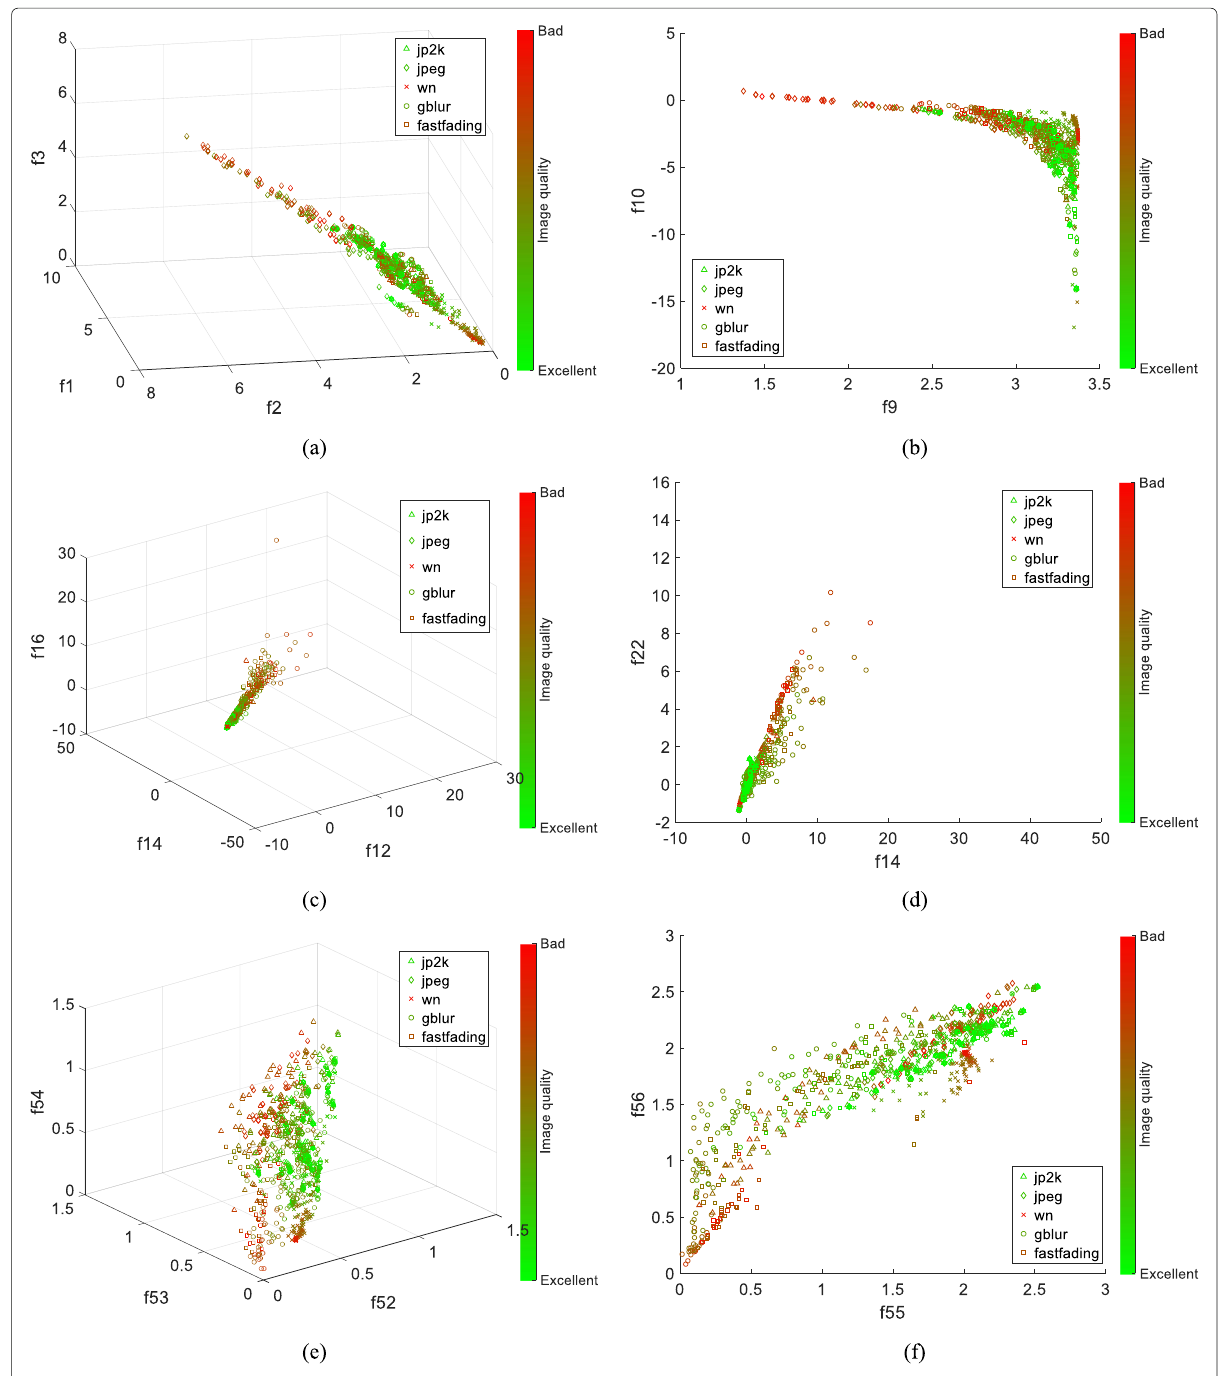
Fig. 4 Illustration of the discriminatory power of different feature combinations (zoom in to get the markers more discriminative). a Elements 1, 2, and 3. b Elements 9 and 10. c Elements 12, 14, and 16 ( d ). Elements 14 and 22. e Elements 52, 53, and 54. f Elements 55 and